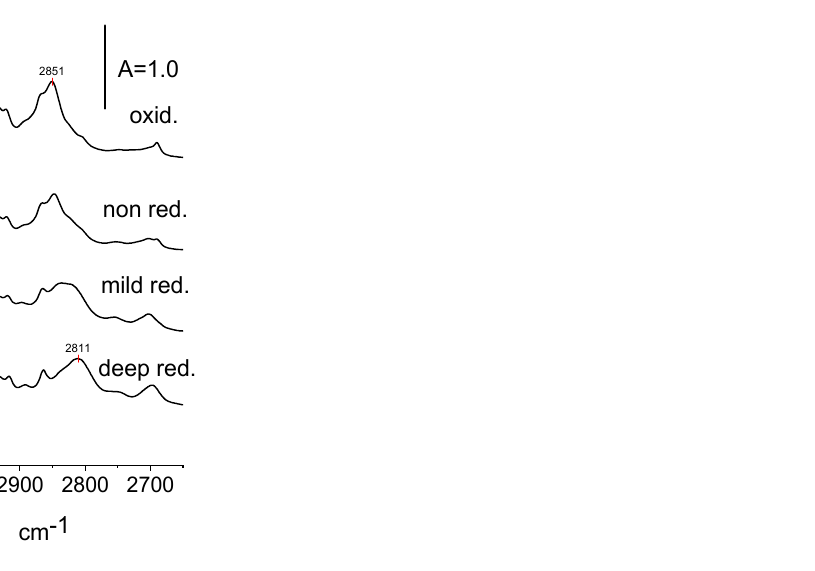
Figure 8. The bands of CH 2 and CH 3 groups in ethoxyls formed on the surface of non-reduced, reduced and oxidized CeO 2 . Table 3. The frequencies of CH 3 and CH 2 groups.